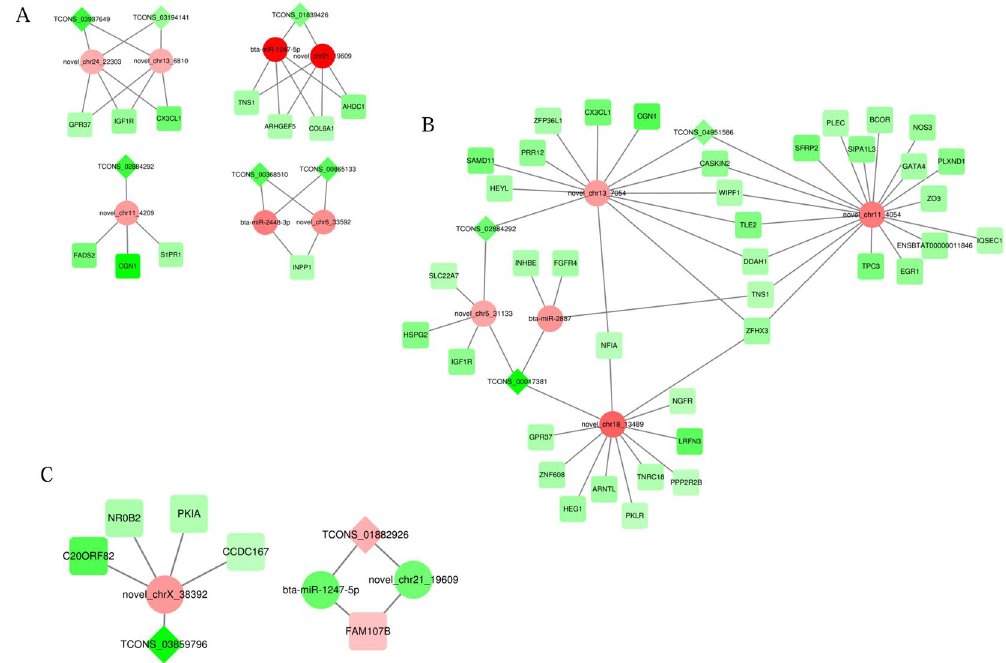
Figure 1. ceRNA regulatory networks among dry period, early lactation, and peak of lactation. ( A ) Early lactation vs. dry period; ( B ) peak of lactation vs. dry period; ( C ) peak of lactation vs. early lactation; red circles, squares and diamonds represent up-regulated miRNAs, mRNAs and lncRNAs, respectively; and the green circles, squares and diamonds represent down-regulated miRNAs, mRNAs and lncRNAs,